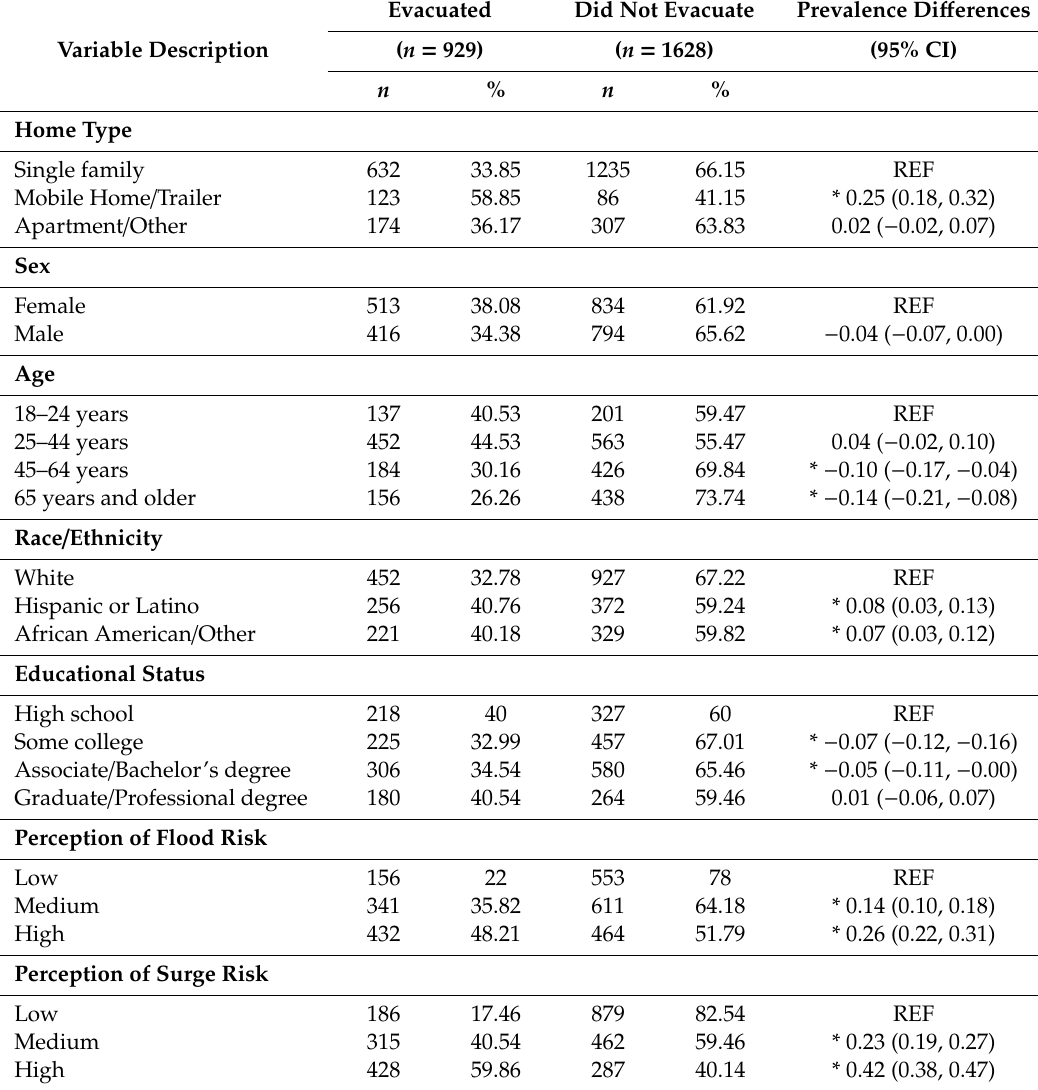
Table 2. Distribution, Crude Prevalence Di ff erences, and 95% Confidence Intervals (95% CI) for Demographic Factors Potentially Associated with Evacuation from Hurricanes in the Gulf Coast in 2017 ( n =